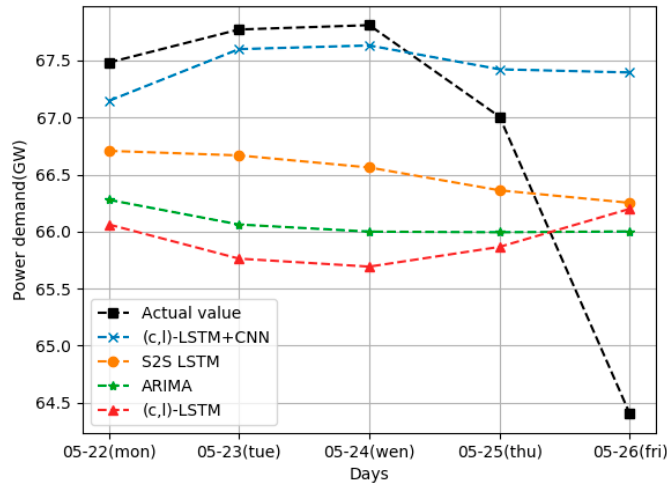
Figure 13. Forecasting performances on d 4 .